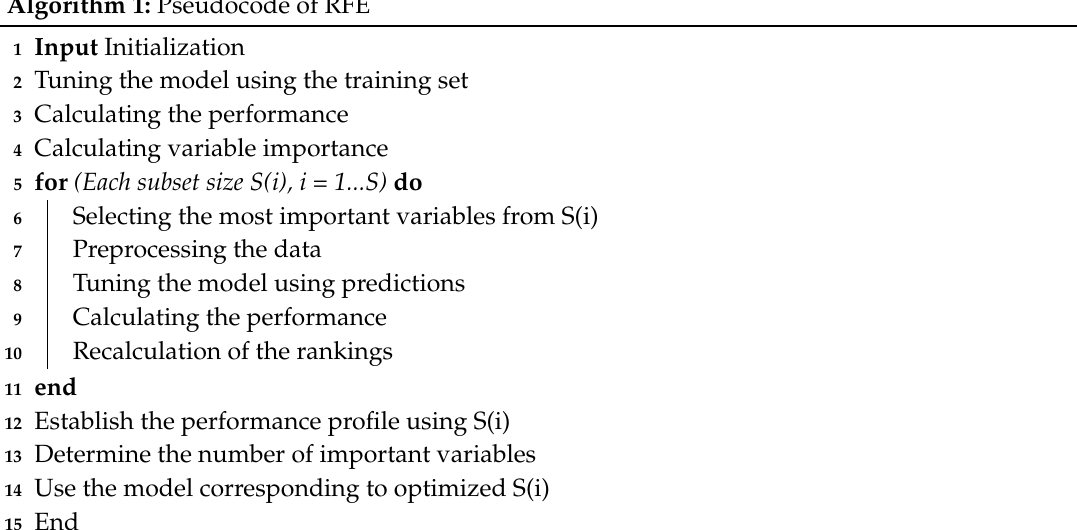
Algorithm 1: Pseudocode of RFE